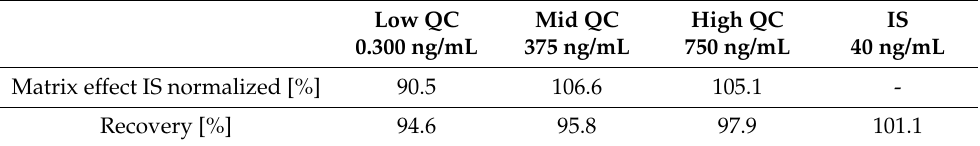
Table 1. Matrix effect and recovery.